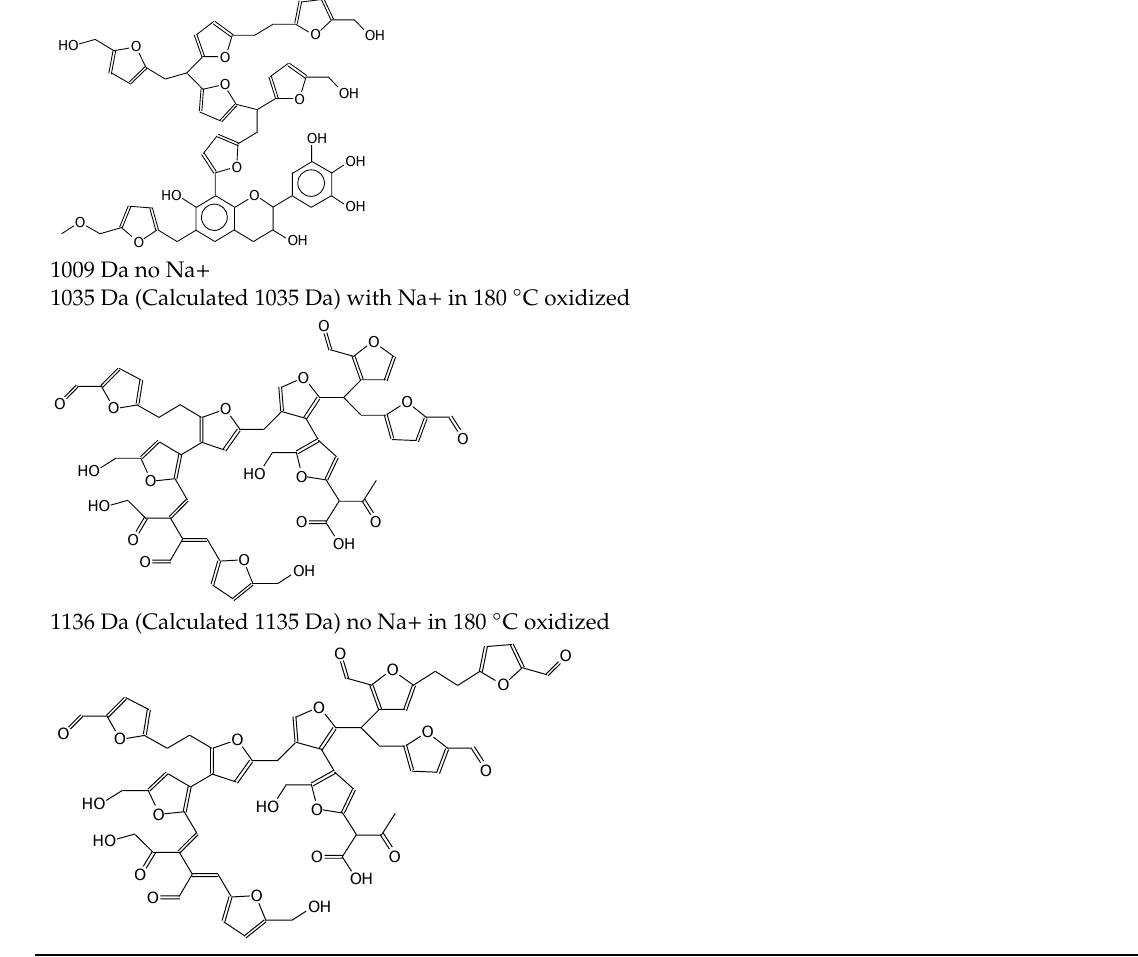
925 Da = (calculated 928 Da) = 912 + 1x-OH, no Na+ 1008 Da (Calculated 1007 Da) with